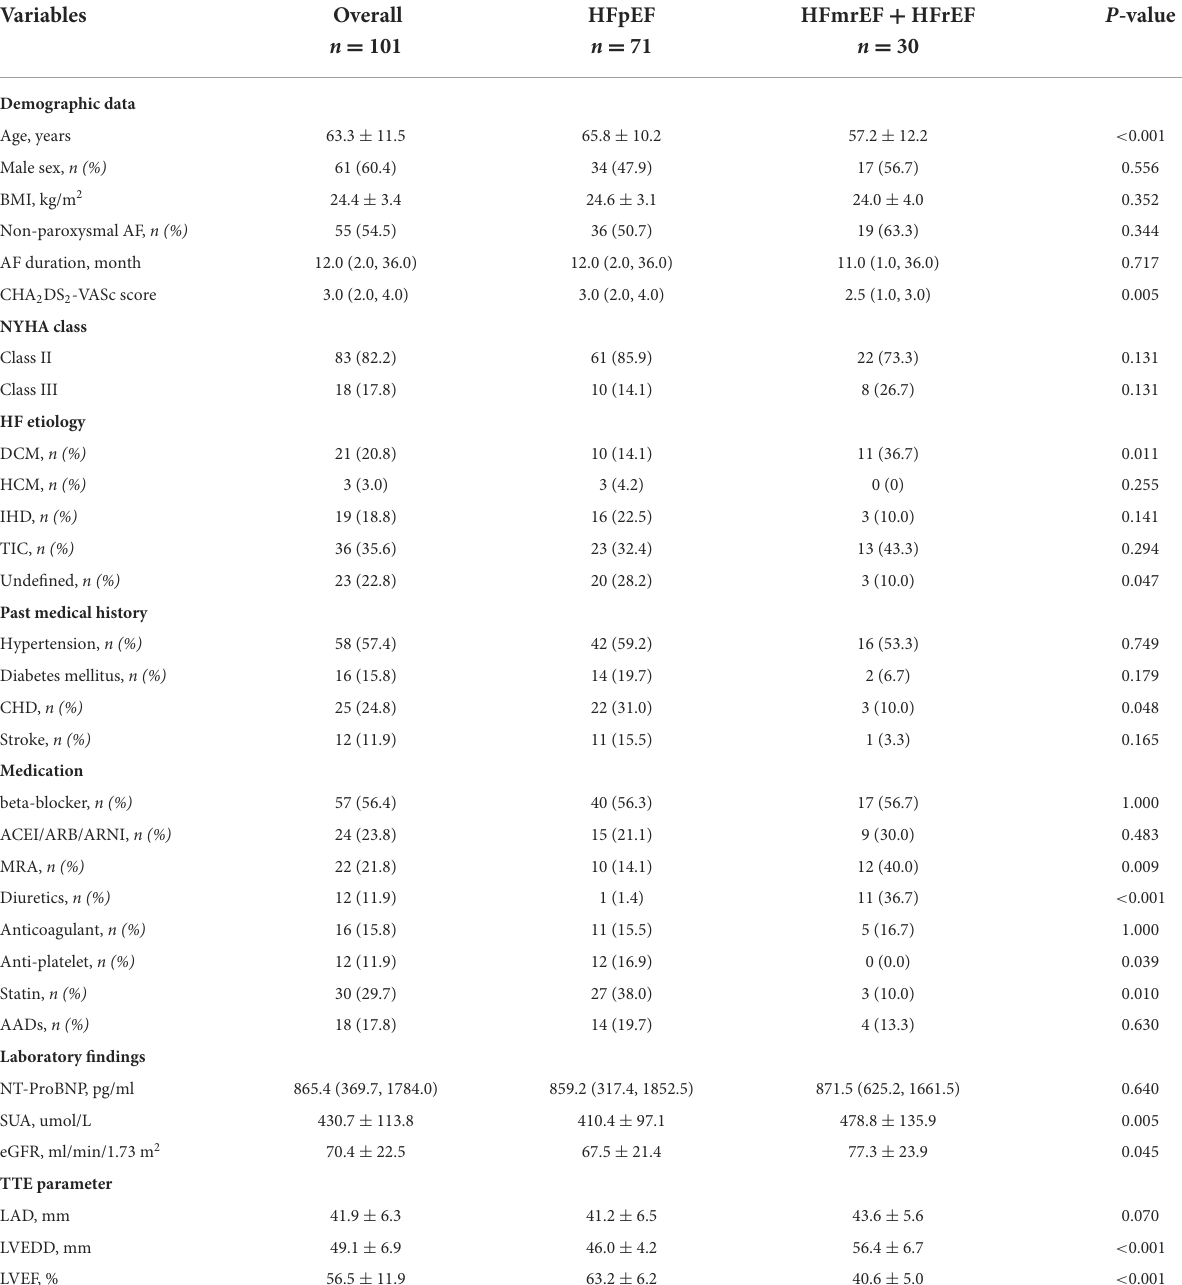
TABLE 1 The baseline characteristics of the study